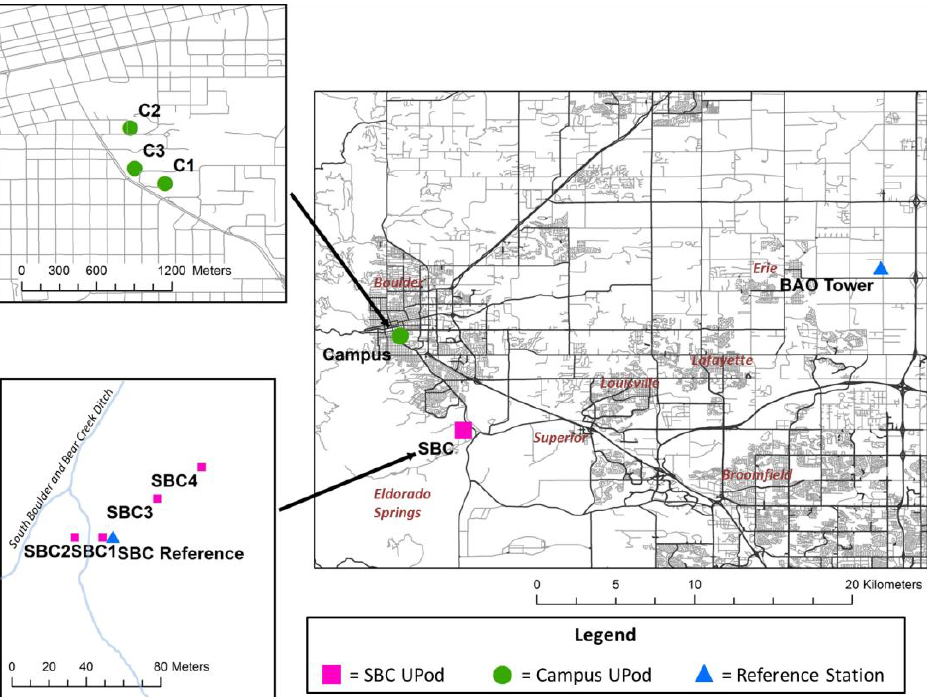
Figure 1. Maps of study area including overall collocation and deployment sites, campus UPod locations, and South Boulder Creek (SBC) UPod locations.